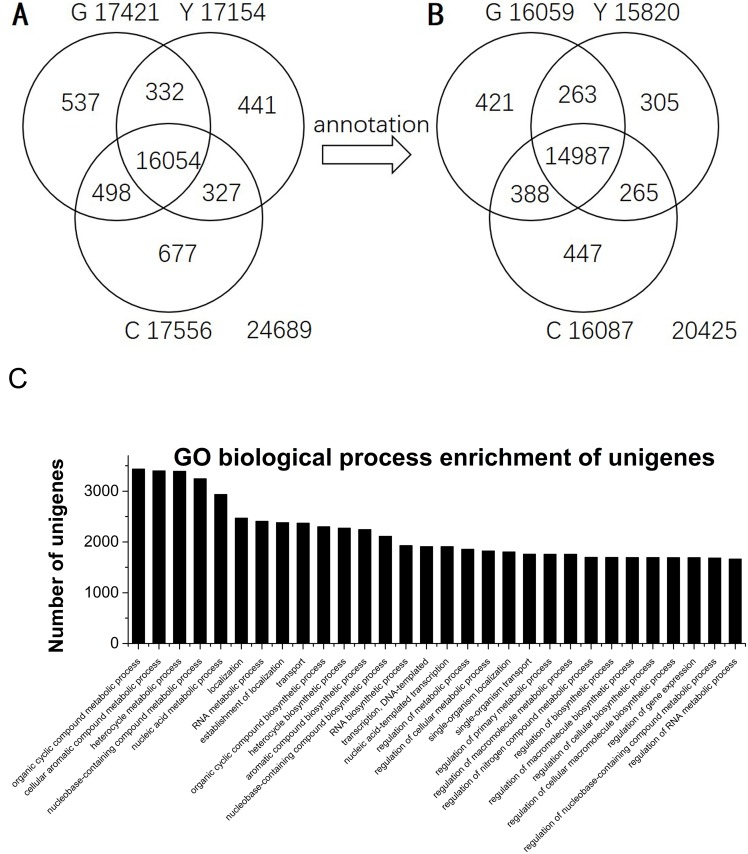
Unigenes distribution in different periods of goat longissimus dorsi muscle at different postnatal stages.A. Unigenes distribution in kid (G), young (Y) and adult (C) goats muscle. B. The distribution of annotated Unigenes in goat muscle at different postnatal stages. C. Top 30 GO biological process categories by GO enrichment of defined Unigenes. Significance level was P<0.05.